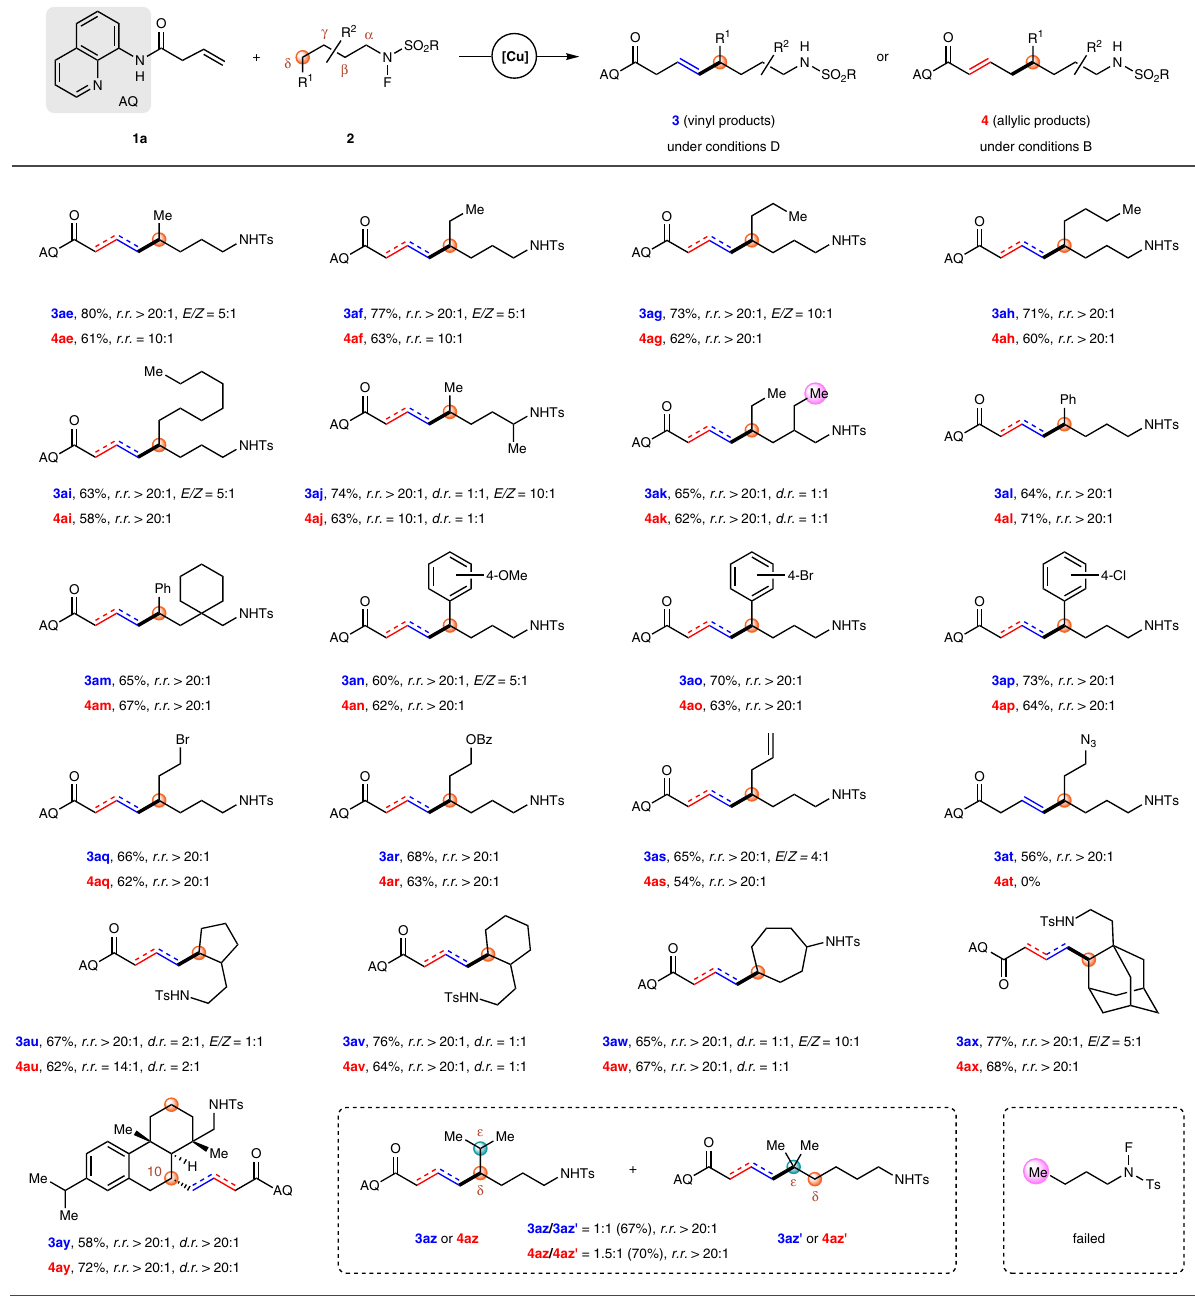
Fig. 4 | Substrates scope of N - fl uoro-amides bearing secondary δ -C – H bonds. Conditions D (for vinyl coupling): 1a (0.20mmol), 2 (0.50mmol), and Cu(OA- c) 2 ·H 2 O (0.02mmol) in i BuOH/dioxane (2.5/0.5mL) at 90°C for 3h; conditions B (for allylic coupling): 1a (0.20mmol), 2 (0.50mmol), Cu(TFA) 2 ·H 2 O (0.02mmol),